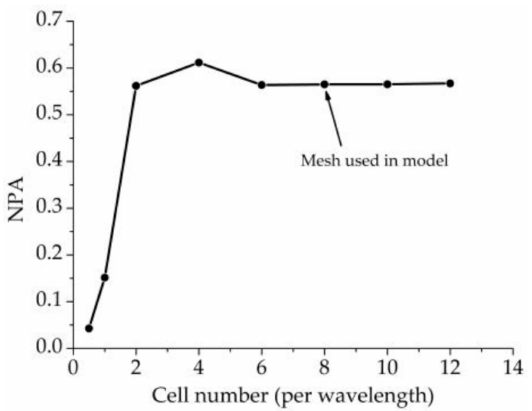
Figure 3. Normalized power absorption (NPA) variation of heating computations with different mesh